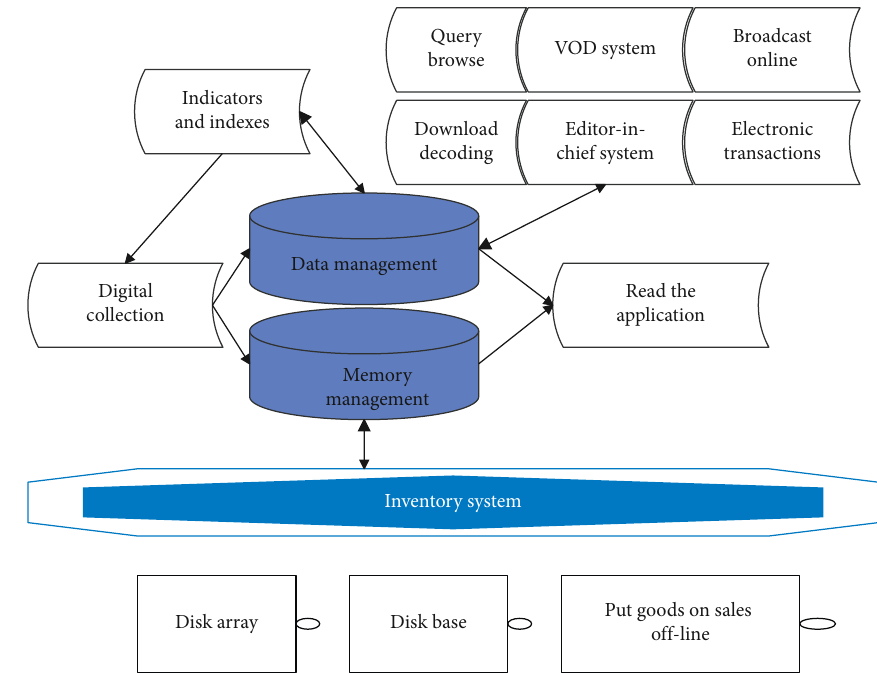
Figure 8: Schematic diagram of subsystem management mode.